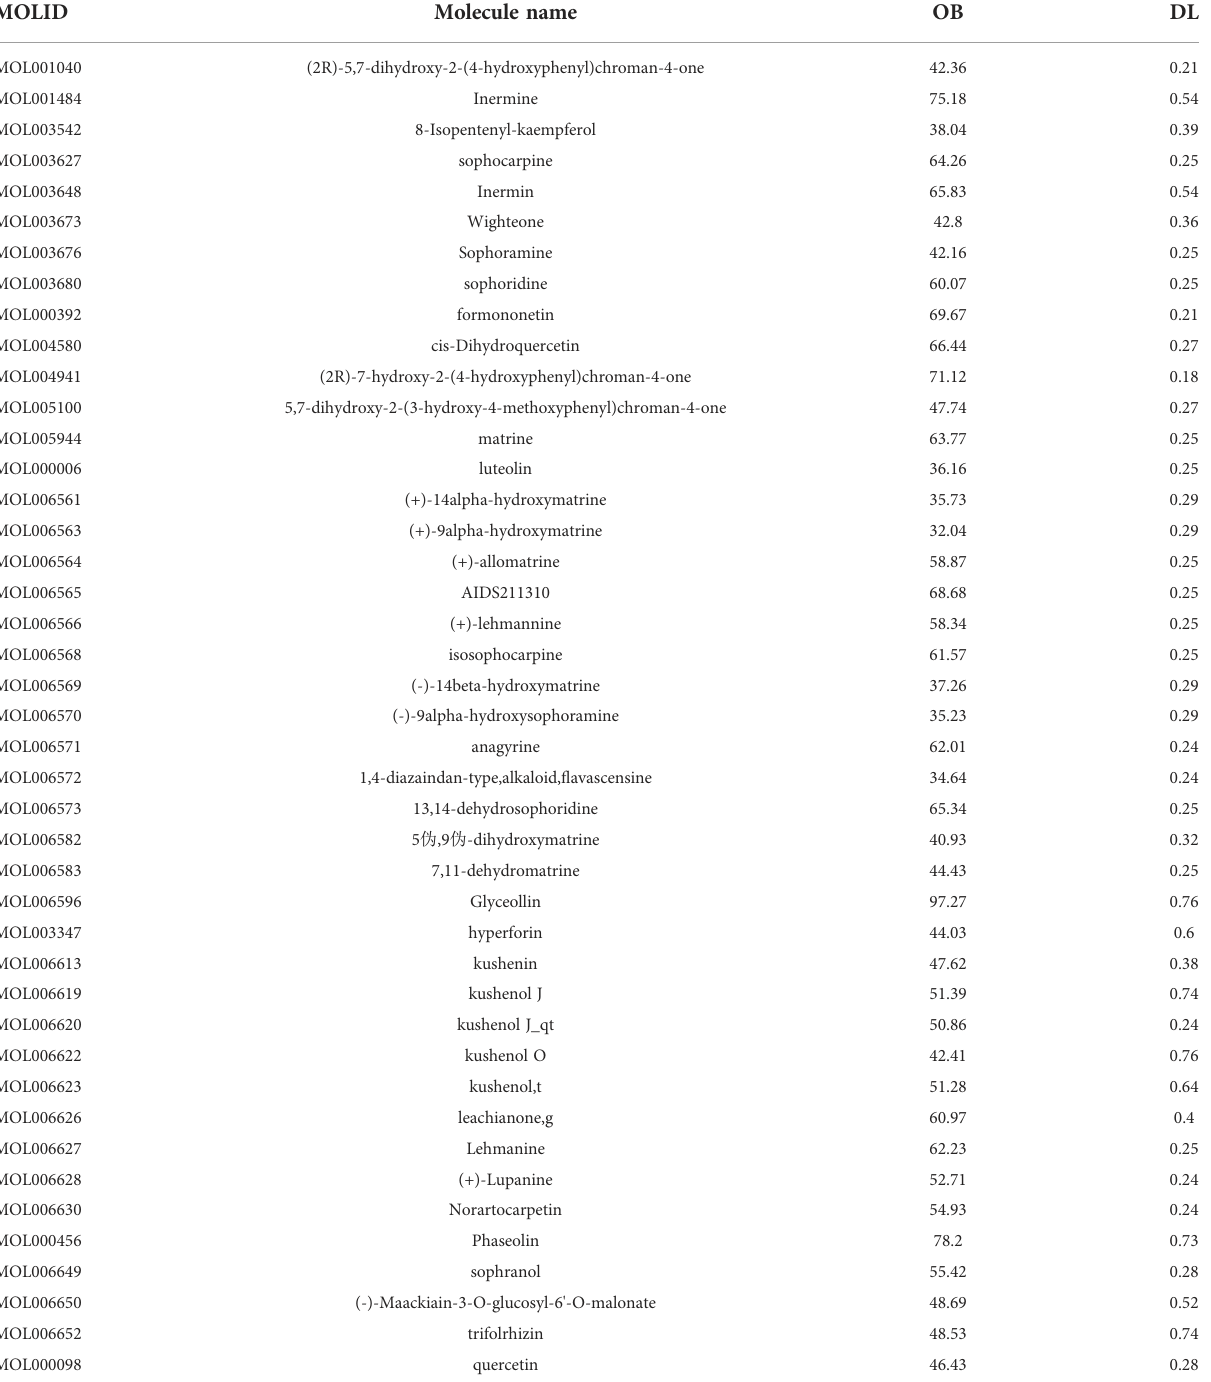
TABLE 1 Core components of